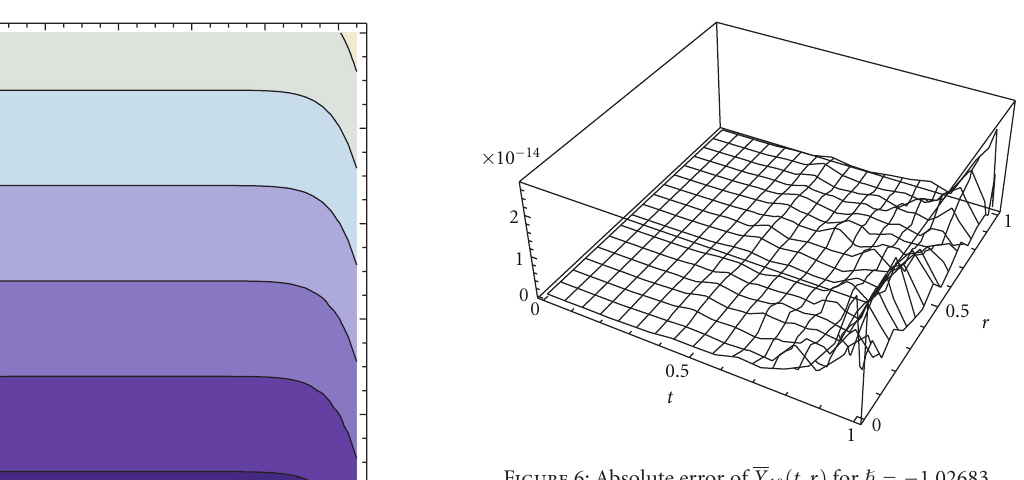
Figure 6: Absolute error of Y 10 ( t , r ) for (cid:2) = − 1 .